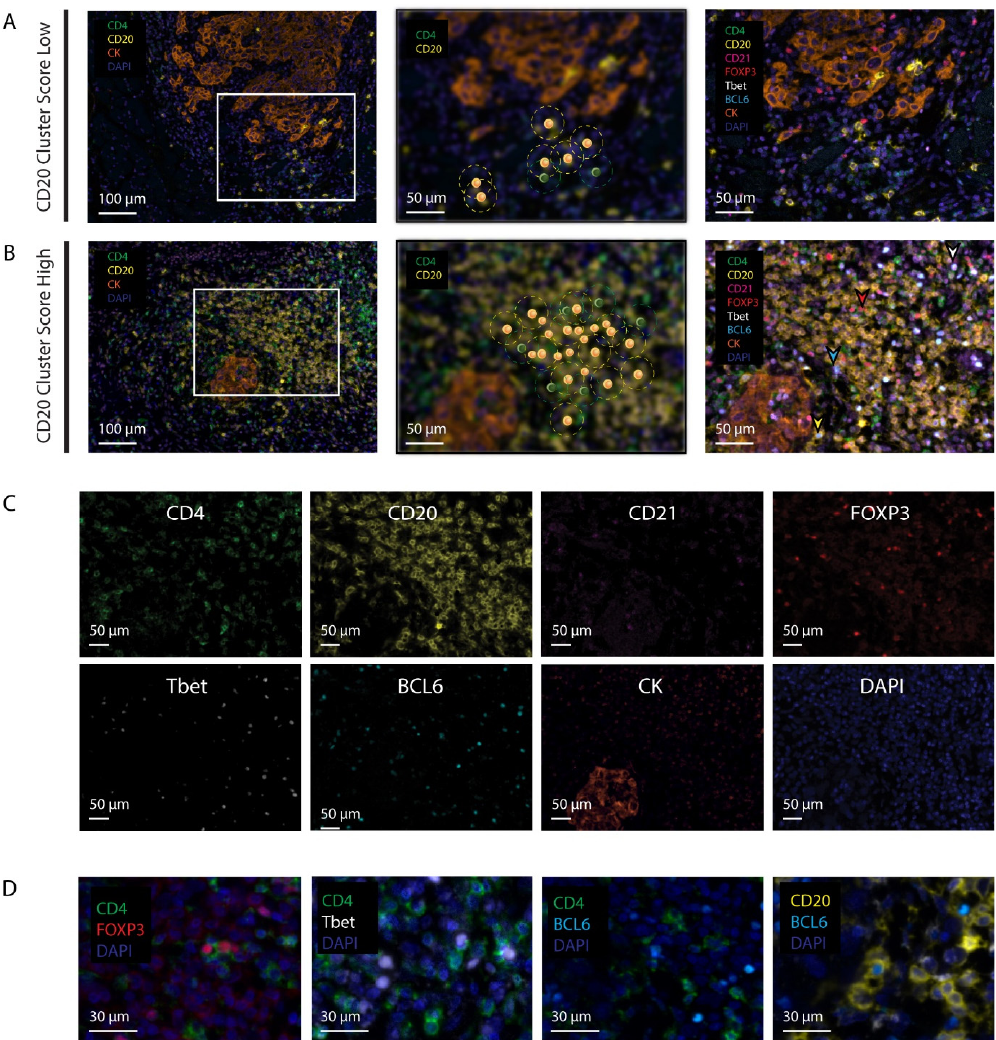
Figure 1. Multispectral images of CD20 cluster score low and high tumors. ( A , B ) Representative images of low CD20 cluster score ( A ) and high cluster score ( B ) tumors. (Left, magnification 20×, the multispectral images of CD4, CD20, CK, and DAPI; Middle, zoomed in, CD20 B cells within 20 μ m radius from either CD4 T cells (CD20WCD4, green dotted line) or CD20 B cells (CD20WCD20, yellow dotted line) are highlighted; Right, accompanying multispectral images of CD4, CD20, CD21, FOXP3, Tbet, BCL6, CK, and DAPI); ( C ) monoplex images for individual markers of a high CD20 cluster score tumor; ( D ) zoomed-in images of double-positive lymphocytes (right, FOXP3+ CD4+ T cell (red arrowhead), Tbet+ CD4+ T cell (white arrowhead), BCL6+ CD4+ T cell (cyan arrowhead), and BCL6+ CD20+ B cell (yellow arrowhead)).